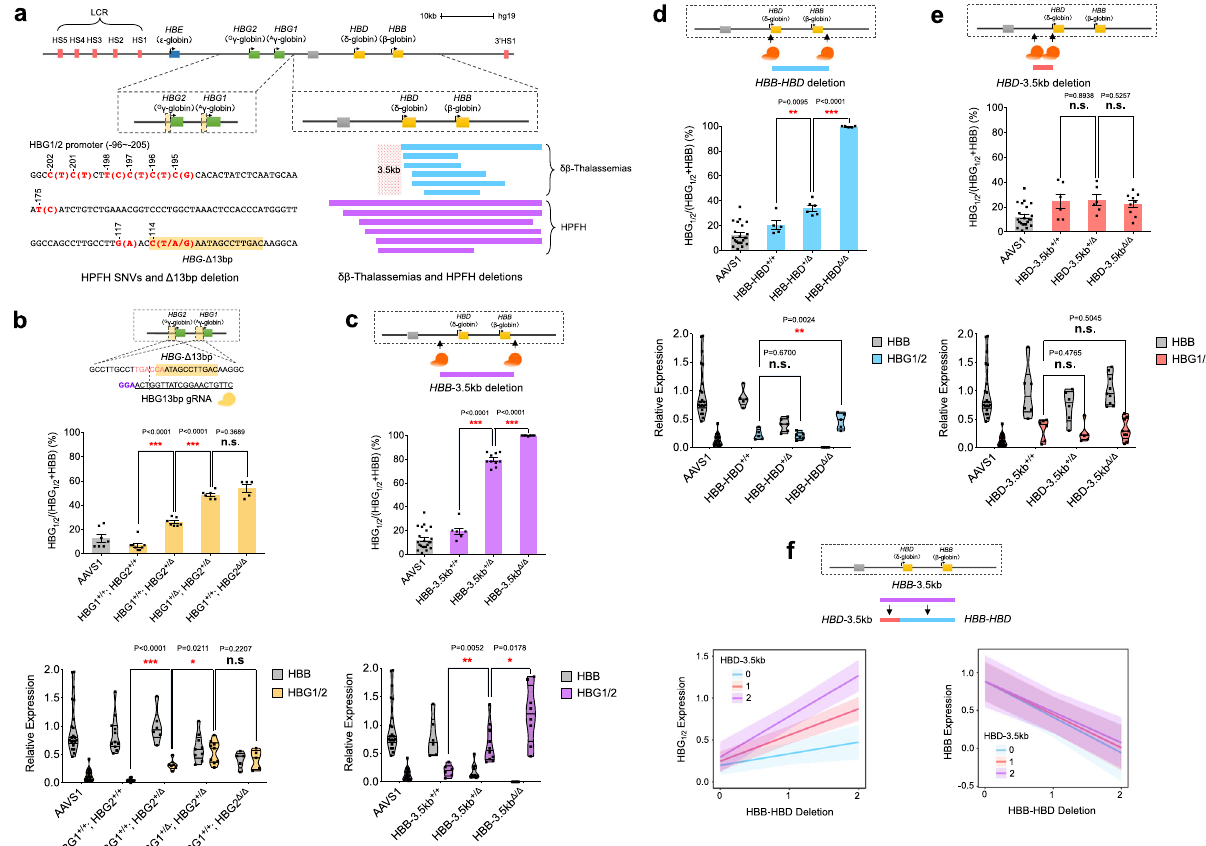
Fig. 1 Modulation of HbF regulation through recapitulation of speci fi c cis -regulatory element perturbations in single cells. a Schematic of HPFH SNVs and HBG - Δ 13bp deletion at the proximal γ -globin promoter and large deletions within the β -globin locus that have been reported in individuals with δβ - thalassemias (blue) and HPFH (purple). SNV single-nucleotide variant, HPFH hereditary persistence of fetal hemoglobin, HBG - Δ 13bp 13 bp deletion at the proximal HBG1 / 2 promoter − 101 to − 114. b Gene expression analysis for γ -globin ( HBG1 / 2 ) and β -globin ( HBB ) mRNA in erythroid burst-forming units (BFU-E) derived from HSPC-derived erythroblasts upon genome editing of HBG - Δ 13bp region in the HBG1 , HBG2 , or both promoters, n = 3 biologically independent experiments. Results are shown as mean ± SEM ( P values are labeled on the top of each comparison. * P < 0.05, *** P < 0.001, n.s. statistically non-signi fi cant by a two-tailed Student ’ s t test). HBG 1 Δ , HBG 2 Δ : editing mutation within HBG - Δ 13bp region. c – e Globin gene expression analysis in BFU-E upon genetic perturbations of elements composing the entire HBB -3.5kb deletion, n = 6 biologically independent experiments ( c ); HBB-HBD deletion, n = 3 biologically independent experiments ( d ); an HBD -3.5kb deletion, n = 3 biologically independent experiments ( e ). HBB -3.5kb Δ : region deletion starting from HBD upstream 3.5 kb to HBB 3 ’ end; HBB-HBD Δ : region deletion starting from HBD TSS to HBB 3 ’ end; HBD -3.5kb: deletion starting from HBD upstream 3.5 kb to HBD TSS. Results are shown as mean ± SEM ( P values are labeled on the top of each comparison. * P < 0.05, ** P < 0.01, *** P < 0.001, n.s. statistically non-signi fi cant by a two-tailed Student ’ s t test). f Quantitative modeling on HBG1 / 2 and HBB mRNA expression from genetic perturbations of elements composing HBB-HBD deletion combined with (red line and purple line)/without (blue line) HBD -3.5kb deletion using a linear mixed model. HBB- HBD deletion (0: + / + ; 1: + / Δ ; 2: Δ / Δ ); HBD -3.5kb deletion (0: + / + ; 1: + / Δ ; 2: Δ / Δ ). Modeling lines and bands are shown as mean ± 95%